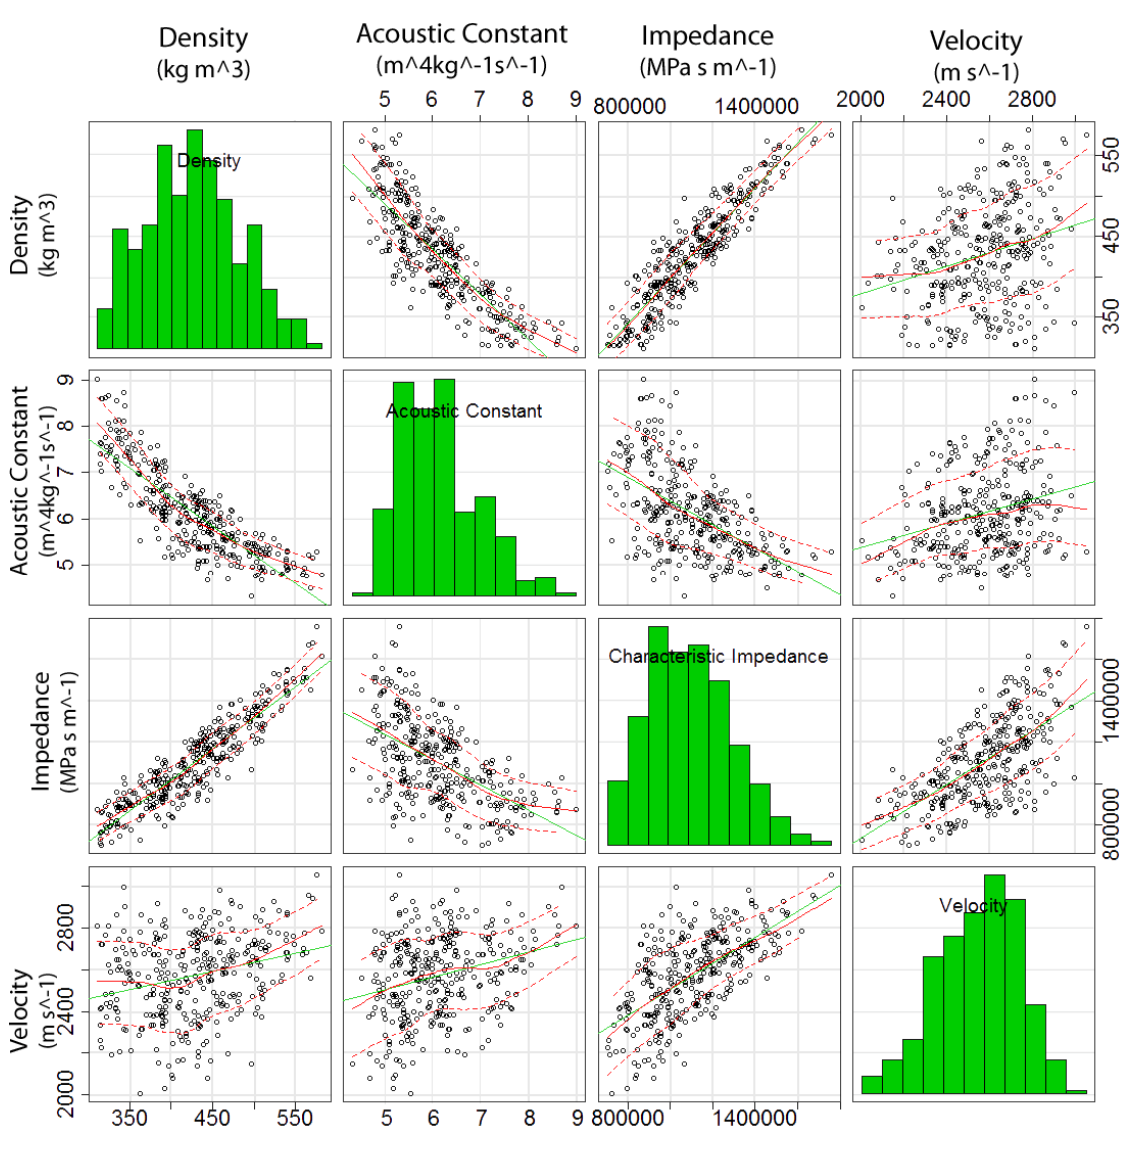
Figure 2. Comparison of physical acoustic